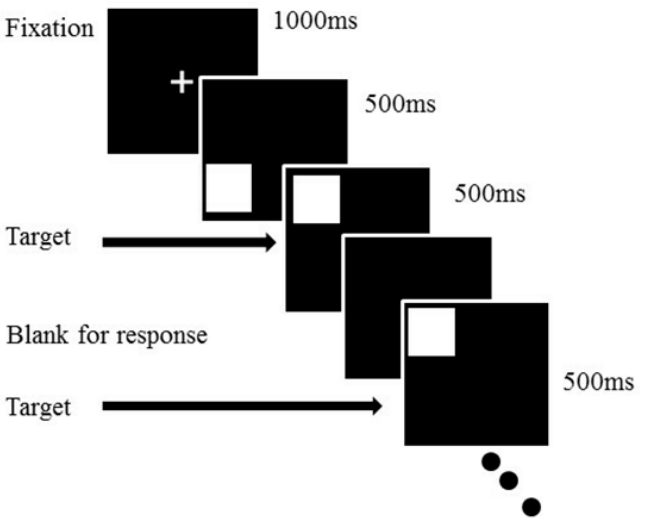
Figure 1. The flow path of the 1-back task. The subjects were required to judge whether the position of the current square was the same as that of the square presented before.